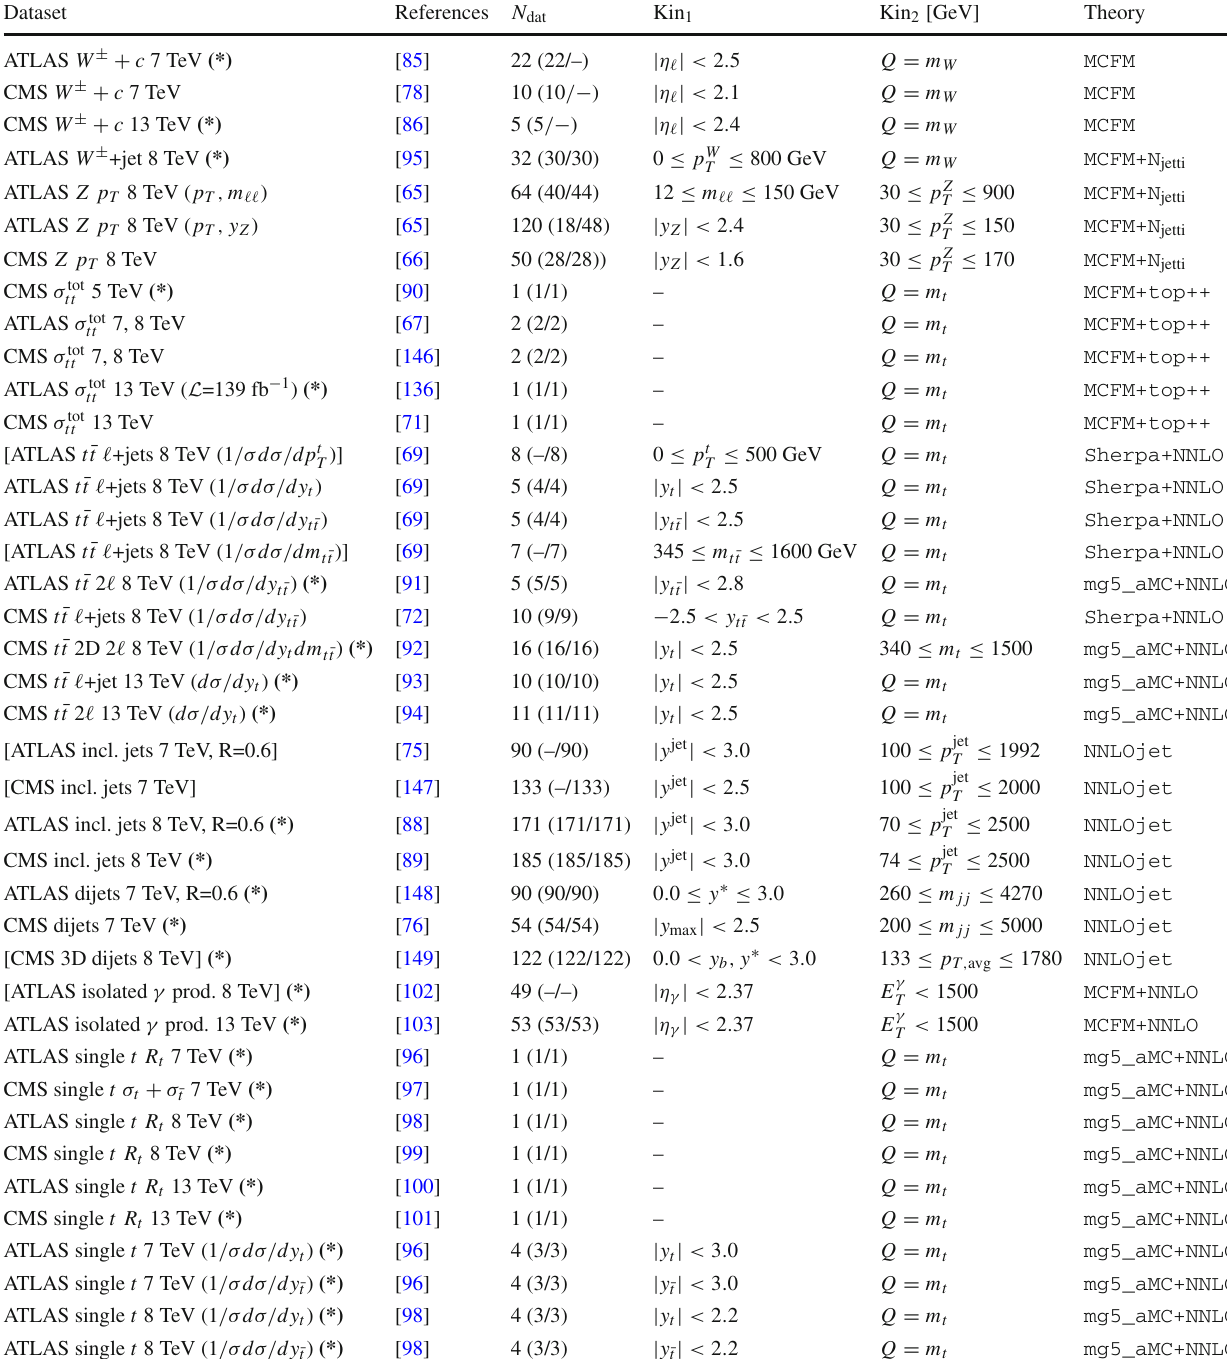
Table 5 Same as Table 1 for other LHC processes. From top to bot- tom we list: W -boson production in association with a jet of charm or of light quarks; Z -boson transverse momentum production; total and